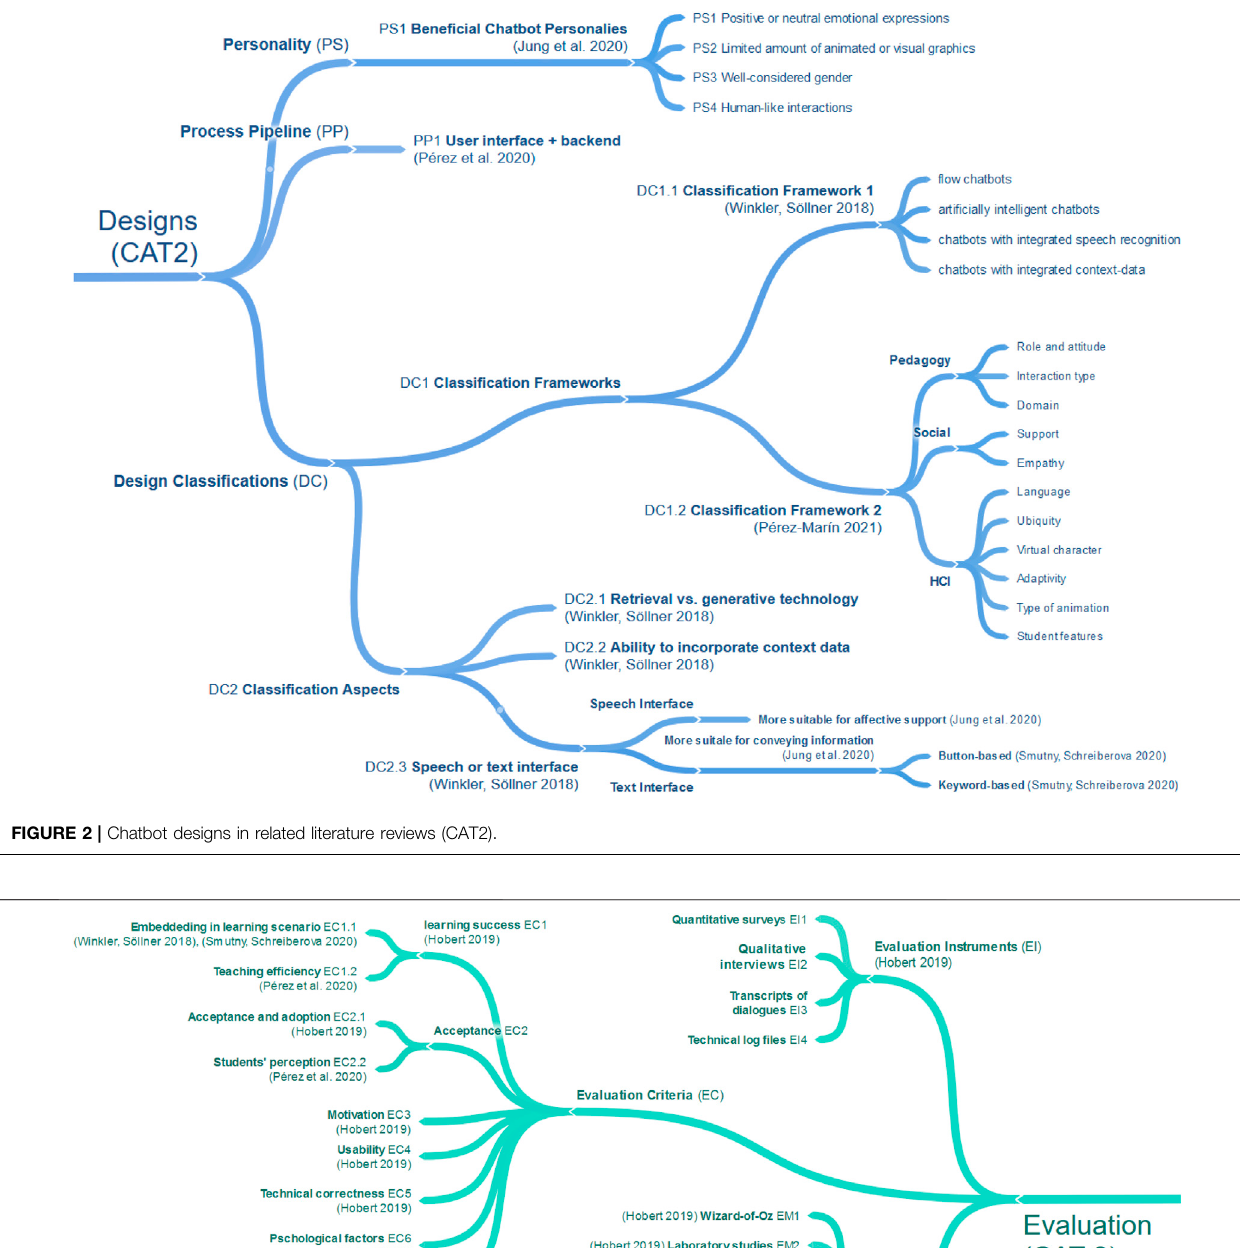
FIGURE 3 | Evaluation of chatbots in related literature reviews